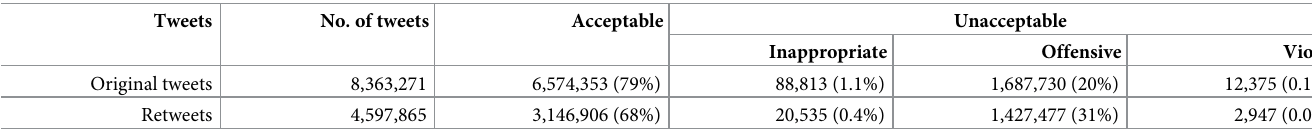
Table 5. Distribution of hate speech classes across the original and the retweeted tweets.